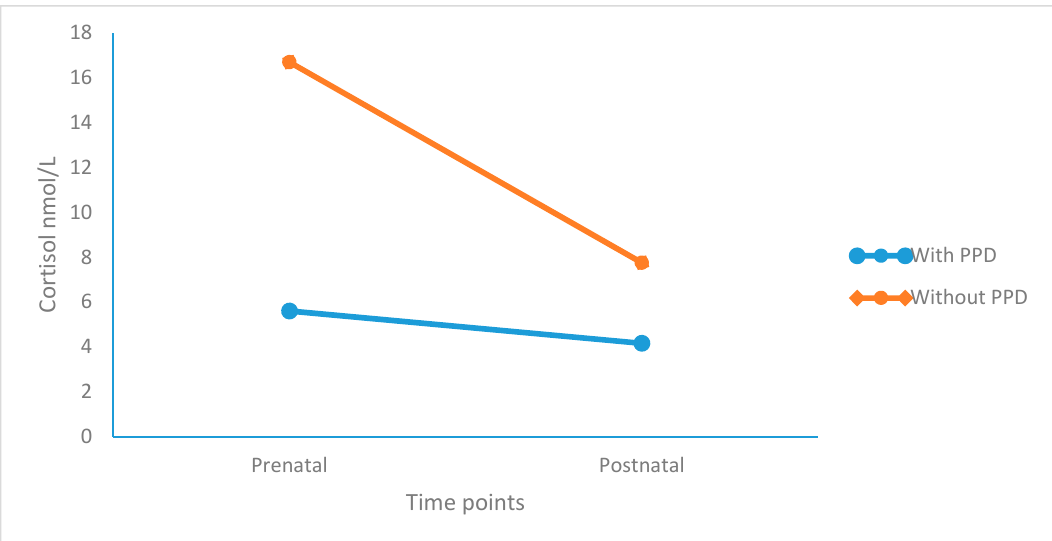
Figure 1. Cortisol levels decreased from prenatal to postnatal stage, but more so in participants without PPD than in those with PPD. In participants with PPD, cortisol secretion remained blunted from the prenatal to postnatal stage. Points are means.